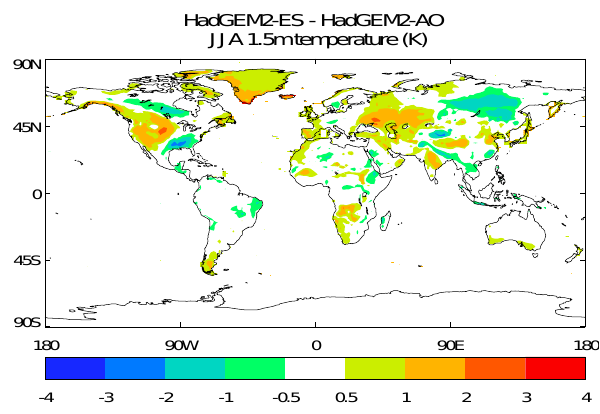
Fig. 22. Comparison of 1.5m temperatures between the earth sys- tem (-ES) and physics-only (-AO) configurations of HadGEM2. Data are 20yr averages for the boreal summer (June, July and Au-